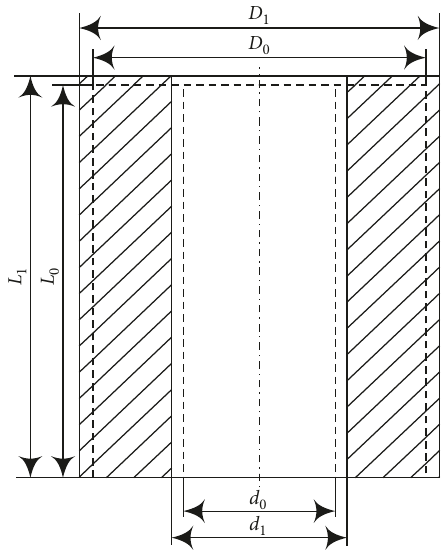
Figure 3: Deformation of the